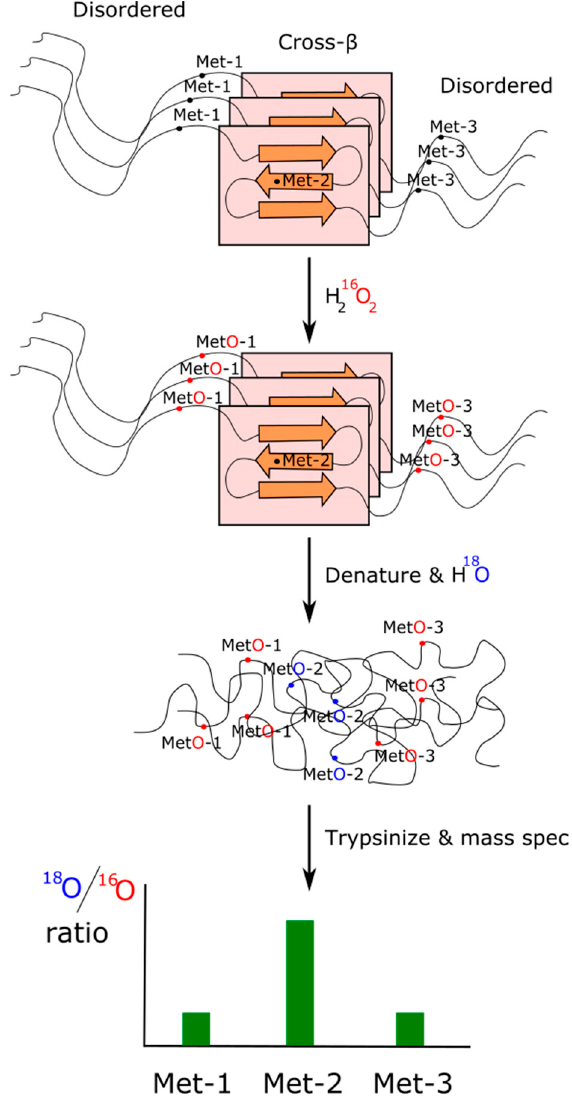
Figure 4. Schematic representation of H 2 O 2 -based footprinting of proteins. Three identical polypep- tide chains, interacting by mean of a cross- β structure, are represented. The N- and C-terminal ends of each chain are supposed to be disordered and contain accessible methionines (Met-1 and Met-3). The central β -sheets also contain methionine (Met-2) but this residue is not accessible as it is protected by the laminated β -sheets that form the cross- β structure. The protein is initially exposed to limiting amounts of 16 O-labeled H 2 O 2 , which will oxidize those methionines being accessible (MetO-1 and MetO-3). Afterwards, the protein is denatured and oxidized to completion with 18 O-labeled H 2 O 2 , allowing the oxidation of Met-2 to MetO-2. Finally, samples are analyzed by mass spectrometry to determine the 18 O/ 16 O ratio of each methionine residue. This figure is a modification of the scheme found in the supplementary materials accompanying the paper